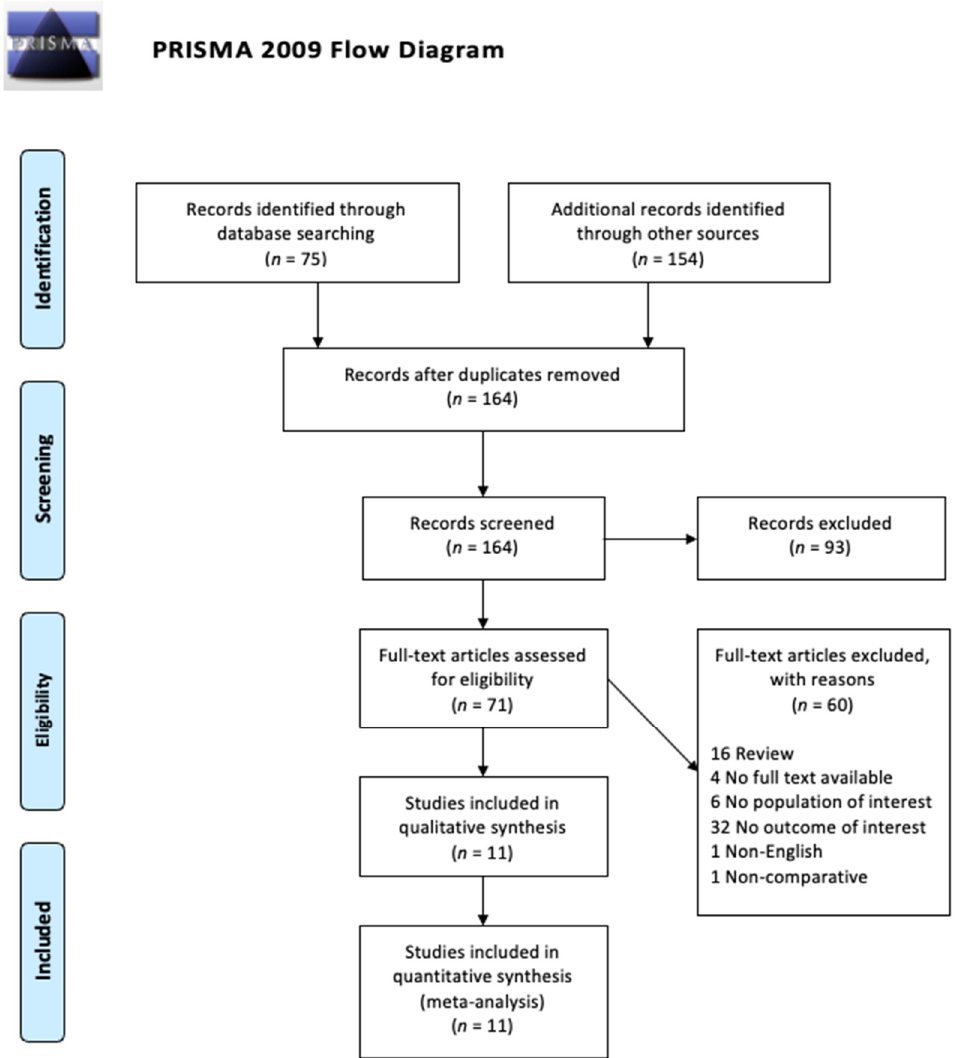
Figure 1. PRISMA Flow Diagram for the study selection